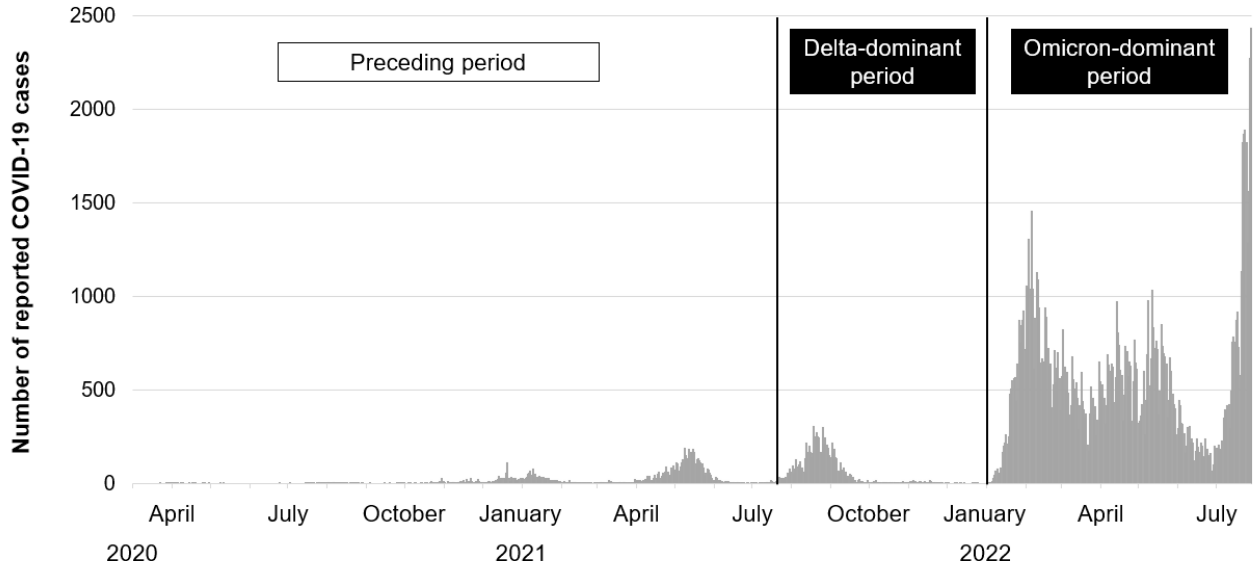
Figure 1. Number of reported COVID-19 cases by day in Okayama Prefecture in Japan and classification of the Delta-dominant and Omicron-dominant periods. The onset of SARS-CoV-2 viral infection in each patient with post COVID-19 condition was classified into three groups based on the epidemiological aspect of COVID-19 in Okayama Prefecture in Japan: preceding, Delta-dominant, and Omicron-dominant periods. The preceding period was the period from the ancestral strain to the Alpha strain, before 18 July 2021; the Delta-dominant period was the period from 19 July 2021 to 31 December 2021, when the Delta variants were dominant after the Alpha-dominant phase; and the Omicron-dominant period was the period after 1 January 2022, when the Omicron variants were dominant in Okayama Prefecture, Japan.